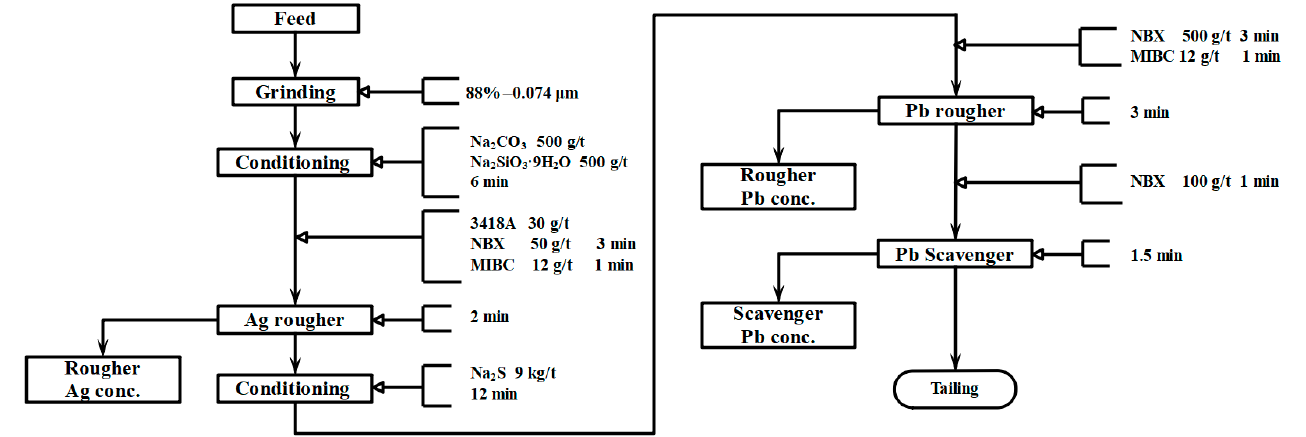
Figure 6. Laboratory flotation flowchart.